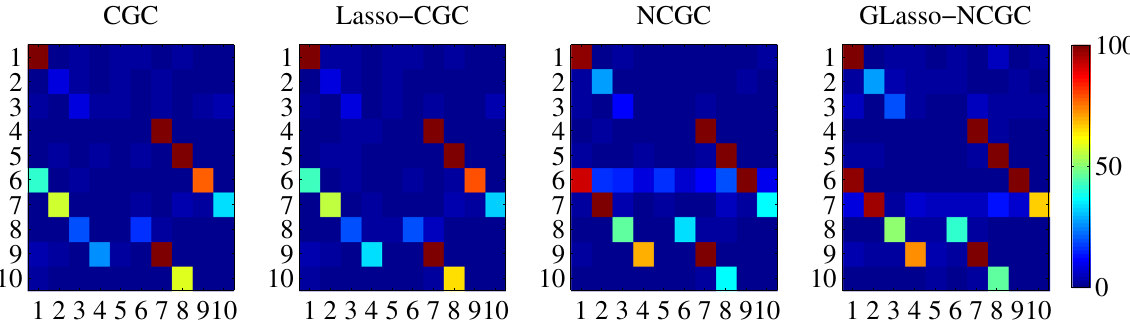
Figure 4. Discovery rate matrixes inferred from 100 realizations in nonlinear VAR simulation.